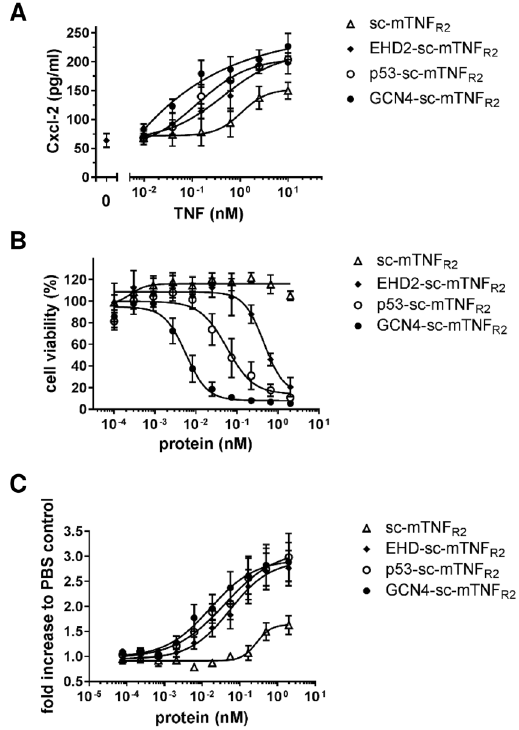
Figure 5. Dodecameric TNF muteins exert elevated bioactivity ( A ) BV-2 cells were incubated for 24 hours with the oligomerized TNF muteins. Then supernatant was harvested and analyzed for presence of secreted Cxcl-2 by ELISA (n = 3 ± SEM). ( B ) Thymocytes were incubated for 4 days in presence of the oligomerized TNF muteins. Then metabolic activity was quantified to determined relative cell numbers (n = 5 ± SEM). ( C ) Kym-1 cells were incubated for 24 hours with the oligomerized TNF muteins. Then cell viability was determined by crystal violet assay (n = 4 ± SEM).